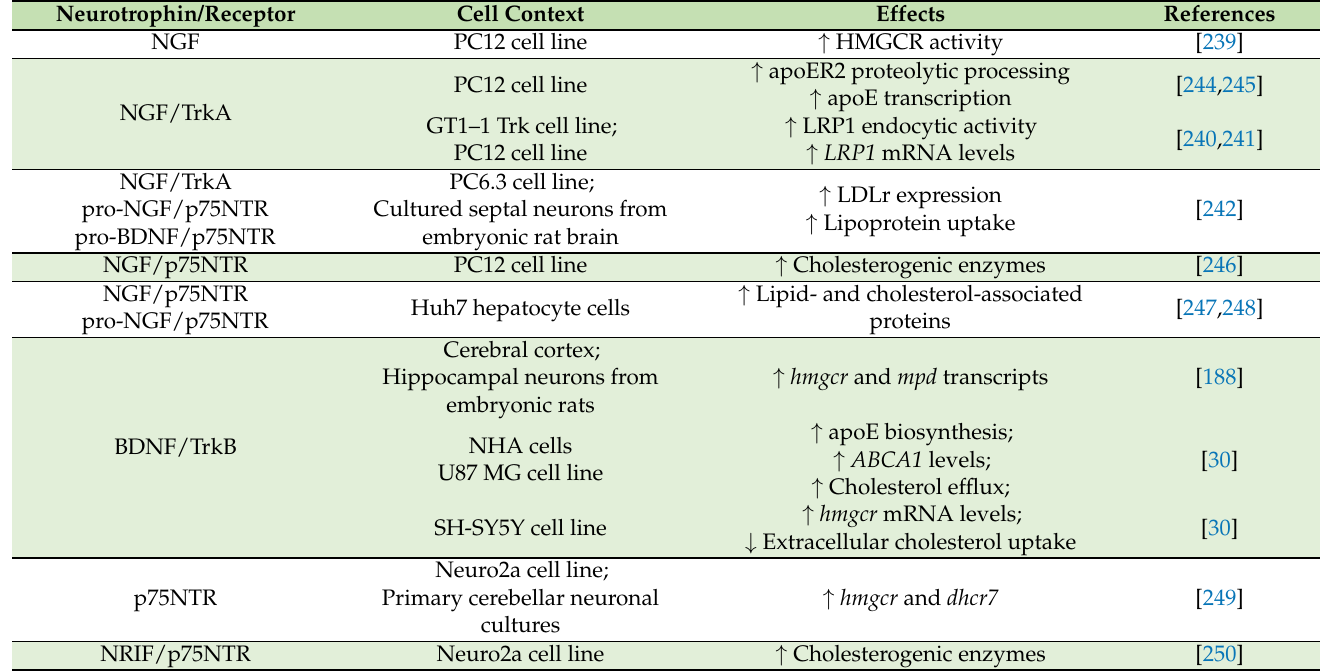
Table 1. List of experimental evidence summarizing the role of neurotrophins in the modulation of cholesterol metabolism. ↑ indicate an increase; ↓ indicates a